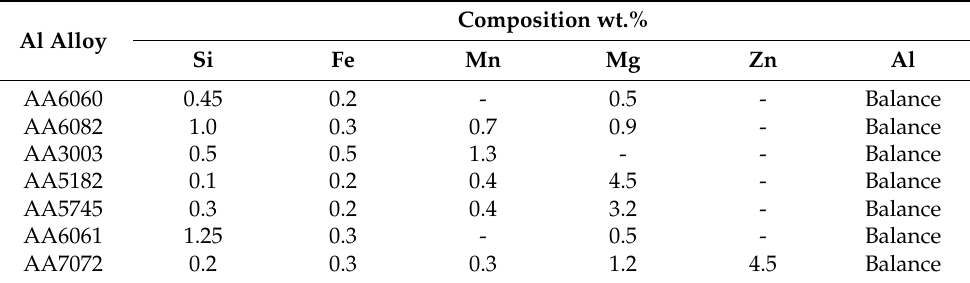
Table 4. Chemical composition of series aluminum